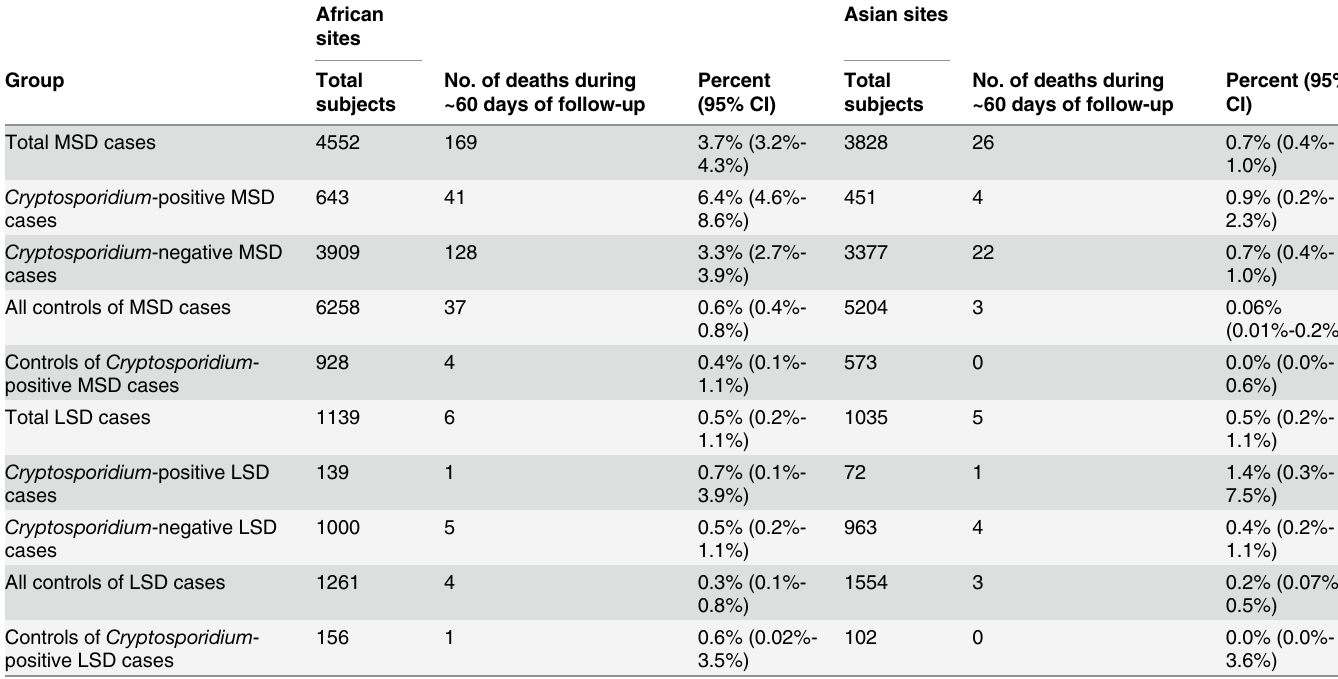
Table 5. Extended fatality risk during ~ 60 days following the onset of acute diarrhea among cases and controls aged 0 – 23 months * .